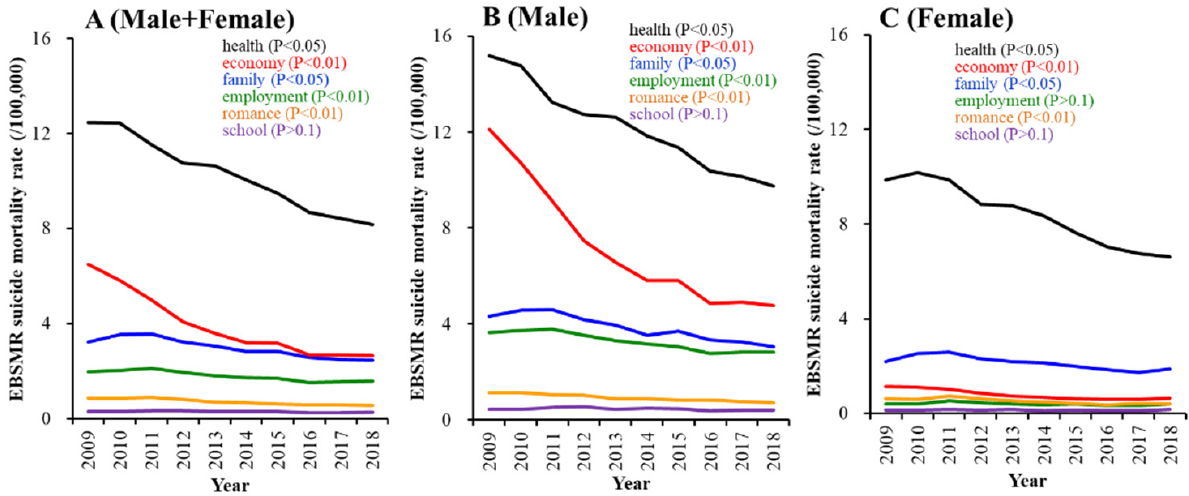
Figure 1. Trends of empirical Bayes standardised mobile ratios (EBSMRs) of suicide mortality in the Japanese population per 100,000 population in males plus females (Male+Female) ( A ), males ( B ) and females ( C ) between 2009 and 2018 were analysed by linear mixed model analysis. Ordinates indicate EBSMR (per 100,000 population), and abscissas indicate time (year). The F-values of the linear mixed model analysis were F motive (5, 119) = 4953.6 ( p < 0.01), F gender (1, 119) = 0.0 ( p > 0.1), F year (9, 119) = 0.0 ( p > 0.1), F motive*gender (5, 119) = 610.7 ( p < 0.01), F motive*year (45, 119) = 2.0 ( p < 0.01) and F gender*year (9, 119) = 0.0 ( p >